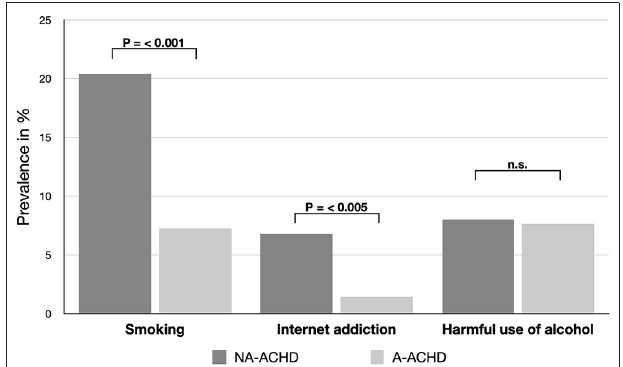
FIGURE 2 | Comparison of lifestyle habits between adherent (A-ACHD) and non-adherent (NA-ACHD) adults with congenital heart disease. n.s., P > 0.05.